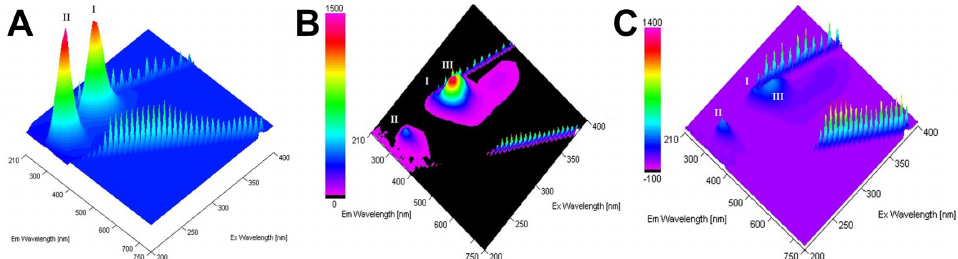
Figure 4. Total fluorescence spectra of the HA ( A ), HA–ORNs ( B ), and HA–ORNs-D-M ( C ) repre- sented in the three-dimensional coordinate system. The amplitude of peaks presented according to the scale panel shown on the left side of the